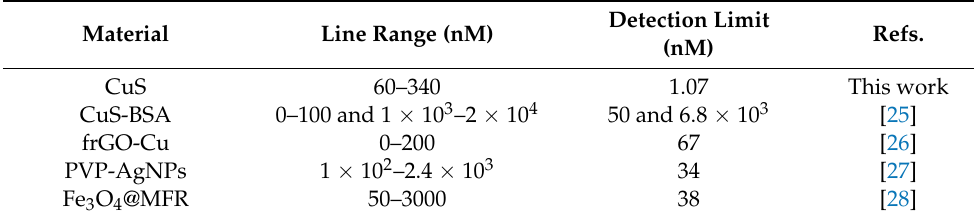
Figure 4. ( A ) The point plot relating to the increased ratio of the absorbance and the concentrations of the Cr(VI), and the linear relationship plot of the Cr(VI) in the concentration range of 60–340 nM (nether inset), as well as the colorimetric assay results adding 0, 60, 90, 125, 190, 285 and 340 nM Cr(VI) (above inset); ( B ) The fluorescence signals produced by CuS + TA (line a), H 2 O 2 + TA (line b), Cr(VI) + TA (line c), Cr(VI) + H 2 O 2 + TA (line d), CuS + H 2 O 2 + TA (line e) and CuS + Cr(VI) + H 2 O 2 + TA (line f); ( C ) Selectivity assay results for the CuS based colorimetric detection method; ( D ) Stability assay results for the CuS storing to avoid light at room temperature for 0, 3, 6, 9, 12 and 15 days. Table 1. The comparison of this CuS based strategy and other nanomaterials based methods for colorimetric determination of